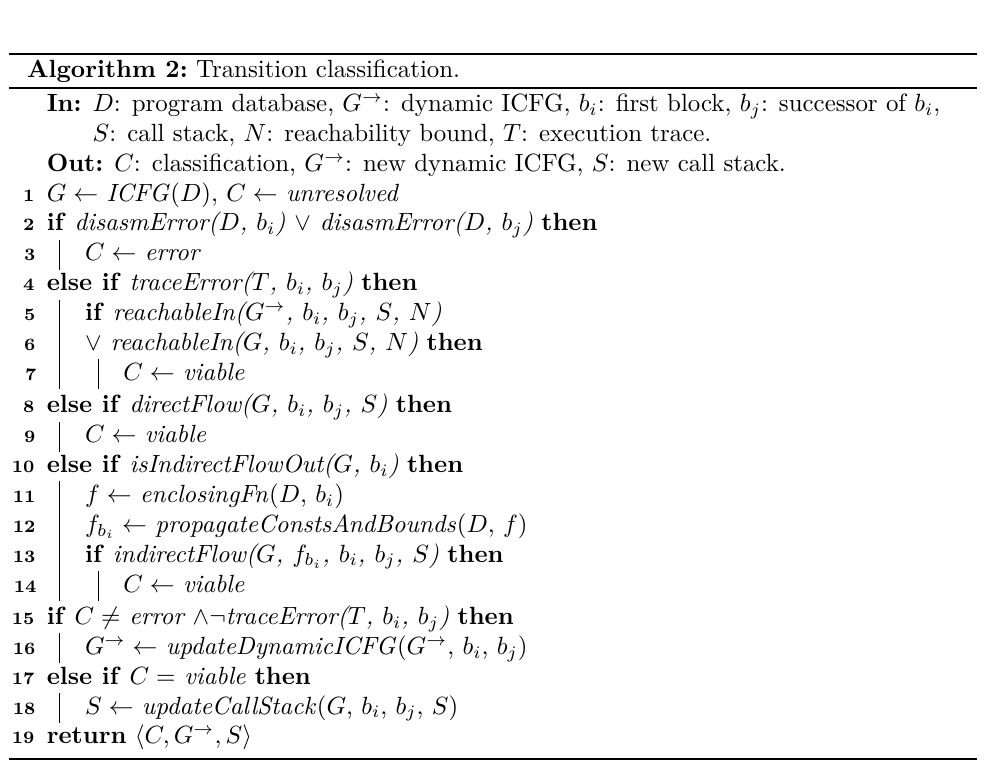
Algorithm 2: Transition classification.